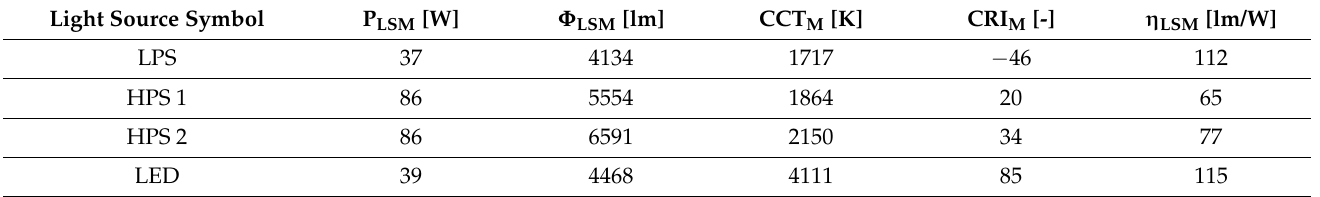
Figure 3. The analyzed light sources installed in the tested luminaires: ( a ) photo of the light sources; ( b ) relative spectral distributions; ( c ) photometric solids; ( d ) light curves. Table 2. Selected parameters of the light sources